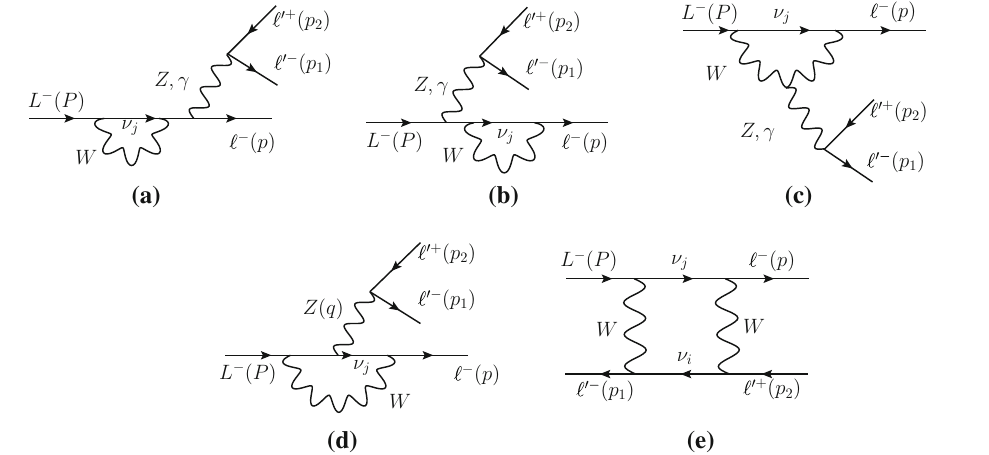
photon. Additionally, when (cid:3) = (cid:3) (cid:5) similar contributions (exchanging p ↔ p 1 ) to the amplitudes of diagrams a – e must be subtracted in order to antisymmetrize the amplitude. On the other hand, when (cid:3) (cid:9)= (cid:3) (cid:5) , since the vertices of the neutral bosons γ and Z with a pair of fermions are flavor-conserving, only a similar e box diagram must be added inter- changing (cid:3)( p ) ↔ (cid:3) (cid:5) ( p 1